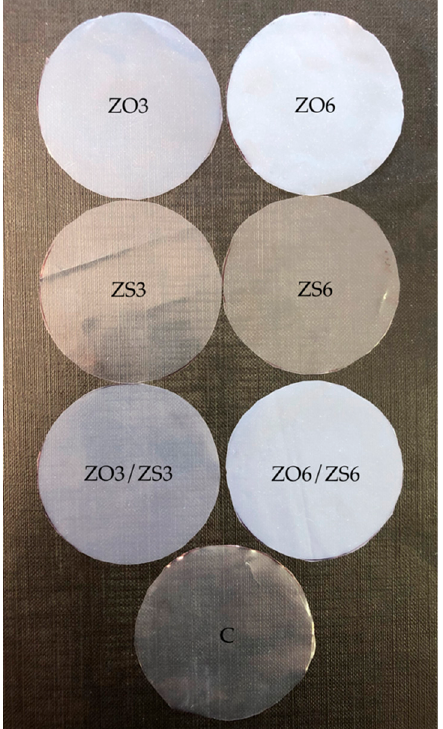
Figure 1. Comparison of the appearance of PE films containing a masterbatch with zinc oxide (ZO) and / or zinc stearate (ZS). (The number next to the additive symbol means its content in the sample in % w / w , C—control sample without zinc compounds).